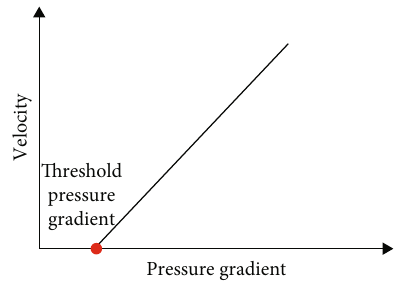
Figure 1: Heavy oil seepage characteristics dynamic